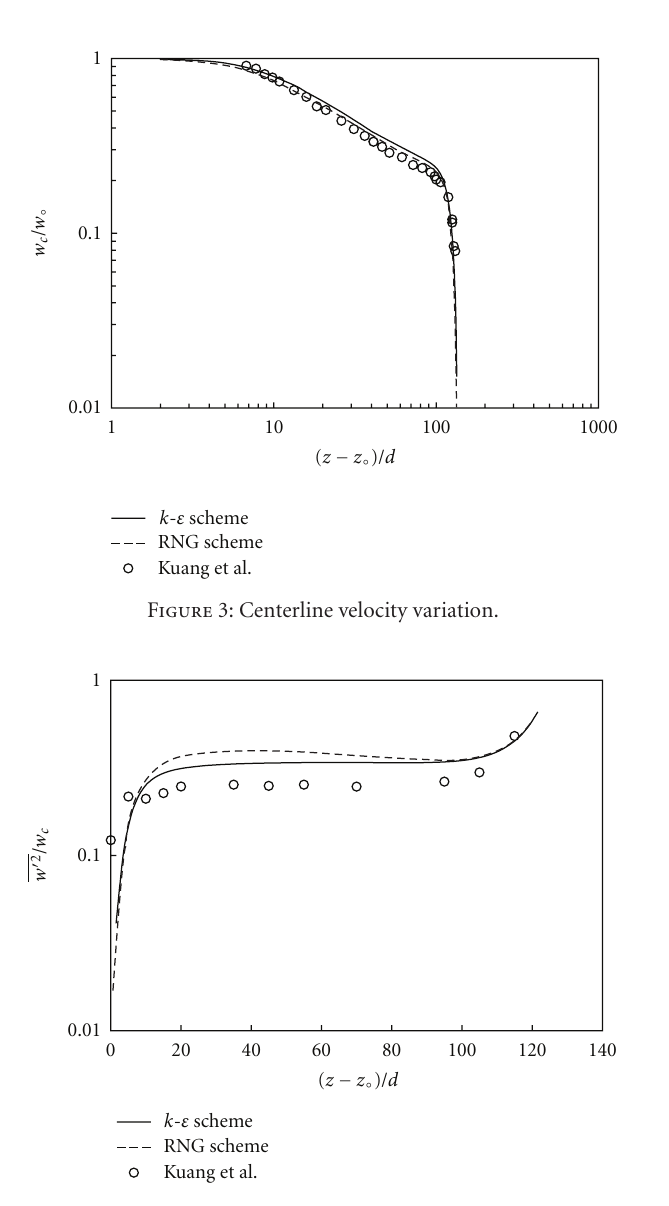
Figure 4: Variation of centerline turbulent velocity fluctuations.